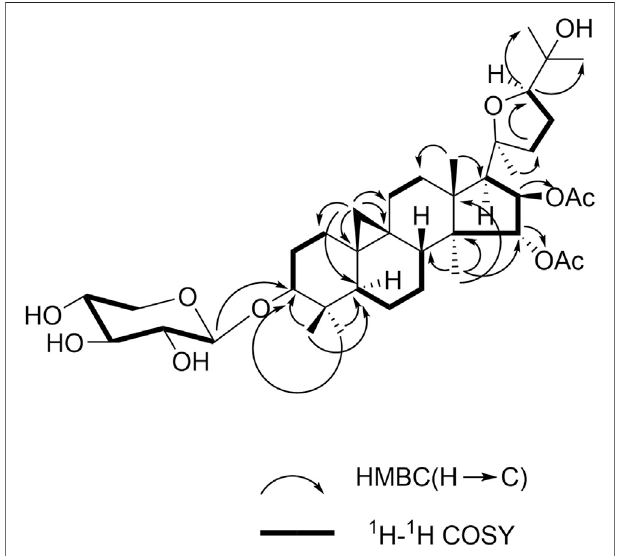
FIGURE 2 | Key HMBC and 1 H- 1 H COSY correlations for 1.